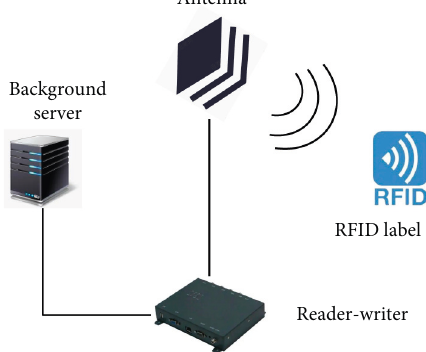
Figure 4: RFID system composition.